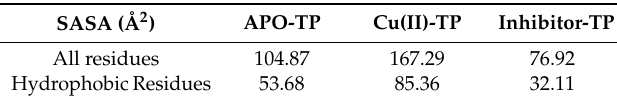
Table 1. Average value of SASA.